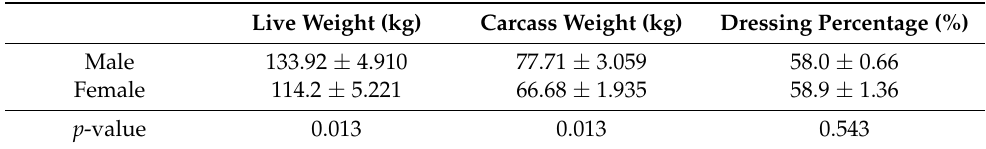
Table 1. Mean carcass yields ( ± standard errors) and least significant differences (LSD) for male and female red hartebeest from Namibia. Live Weight (kg) Carcass Weight (kg) Dressing Percentage (%) Male 133.92 ± 4.910 77.71 ± 3.059 58.0 ± 0.66 Female 114.2 ± 5.221 66.68 ± 1.935 58.9 ± 1.36 p -value 0.013 0.013